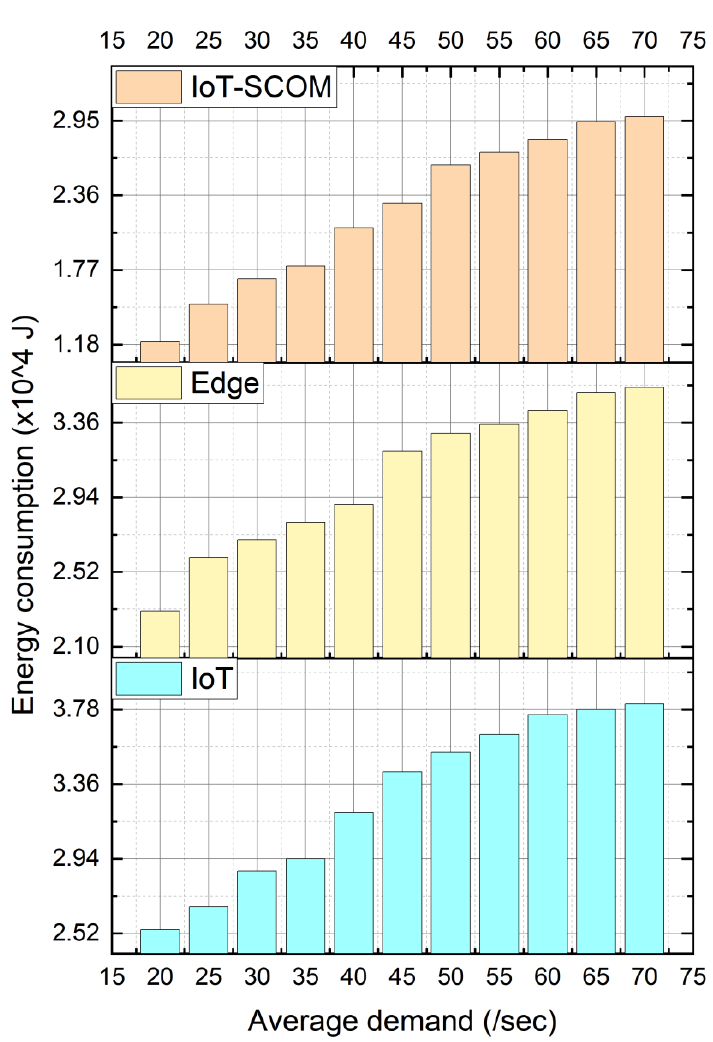
Figure 7. Energy consumption analysis.